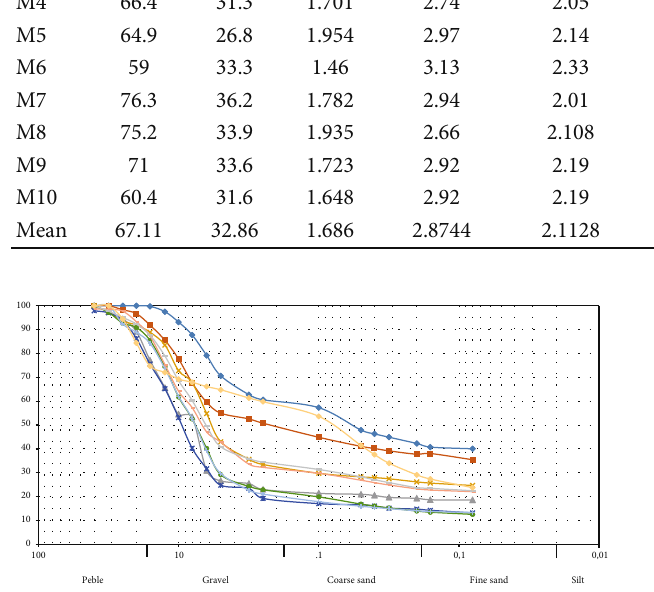
Figure 5: Sieve analysis of laterite in the plutonic